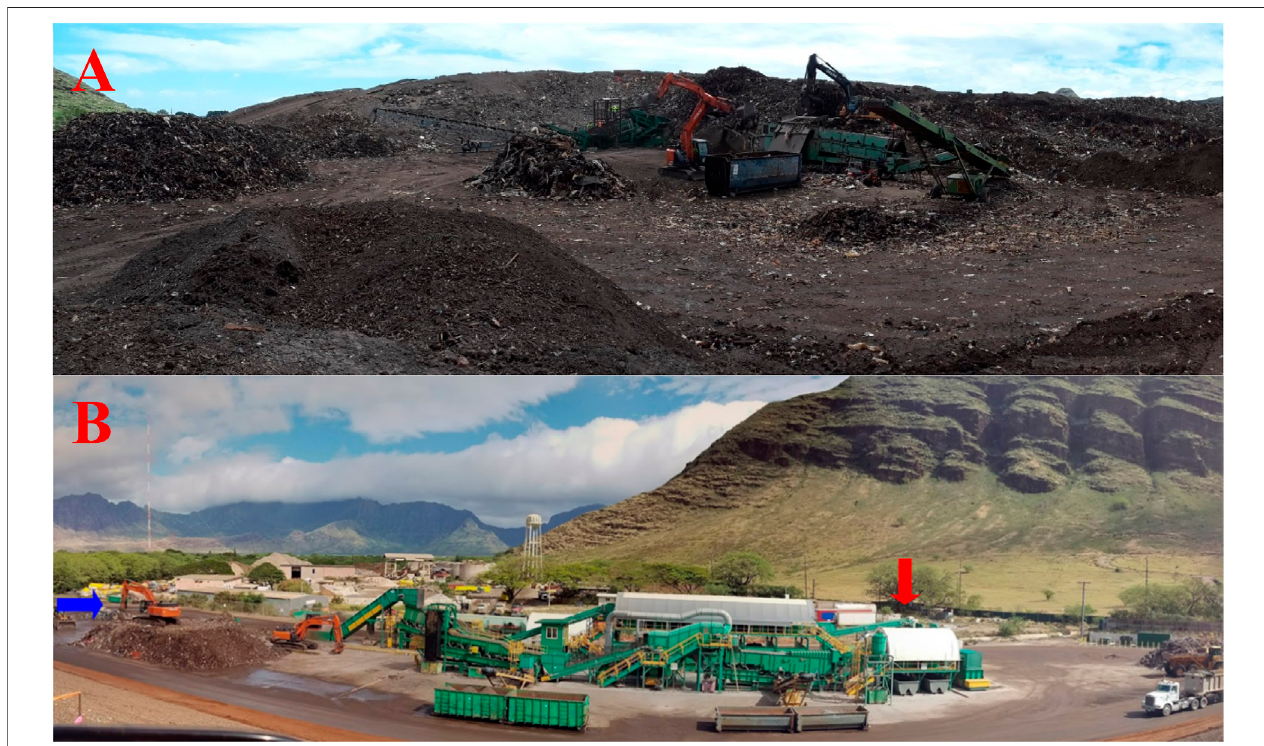
FIGURE 1 | CDWDF materials (A) mining and (B) processing at PVT Land Company (blue arrow: CDWDF intake, red arrow: CDWDF sampling position).